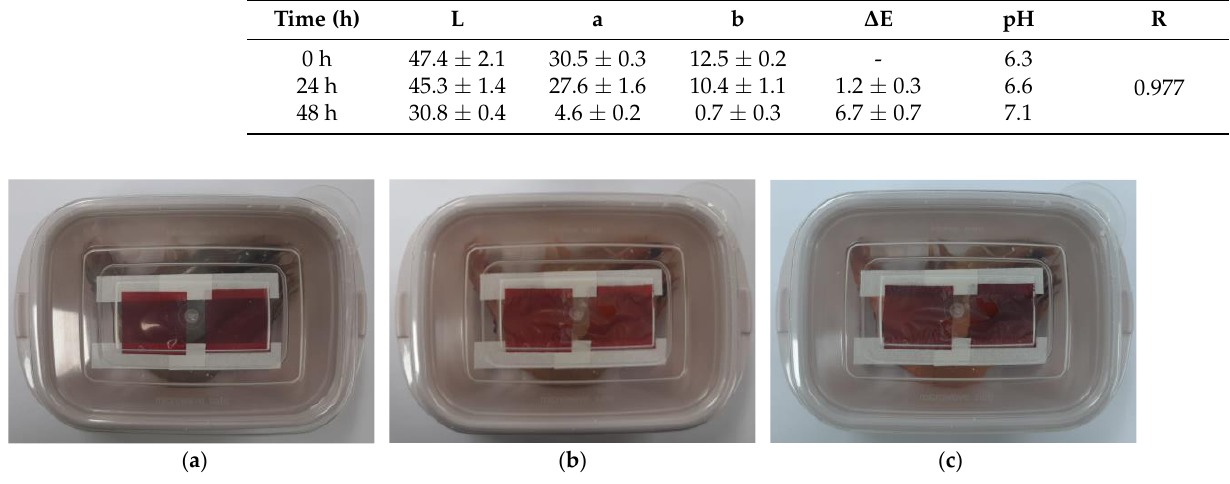
Figure 8. Color changes in the indicator attached to packages of shrimp, ( a ) after packaging, ( b ) after one day, and ( c ) after two days of storage at 25 °C.